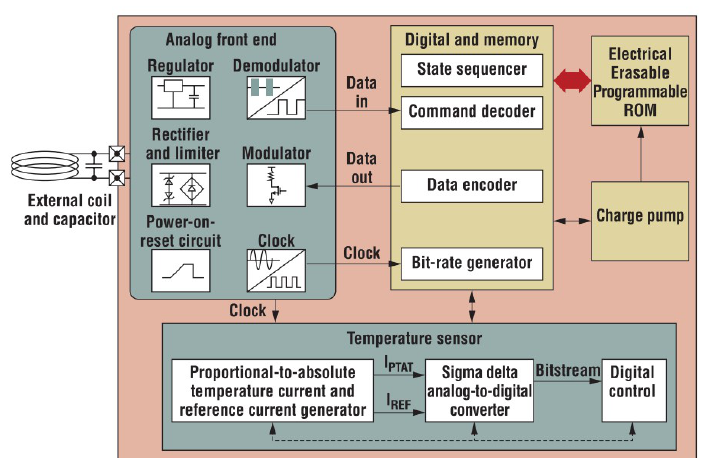
Figure 12. A chip-level block diagram of a chip-based digitally interfaced RFID sensor [23].